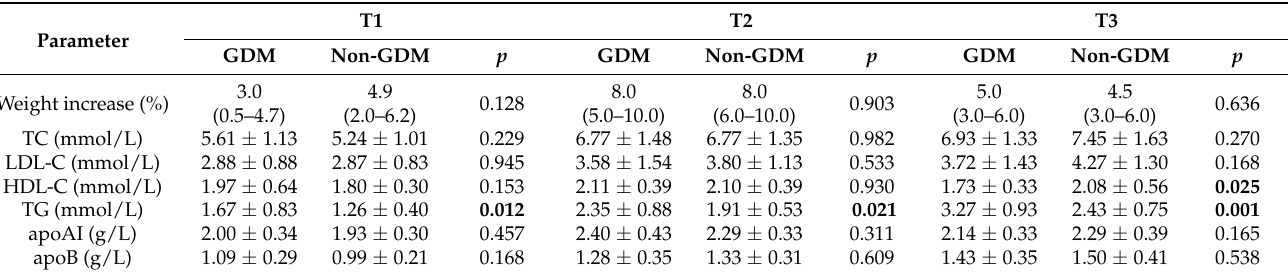
Table 2. Differences in weight increase and serum lipid parameters among pregnant women with and without GDM across trimesters.